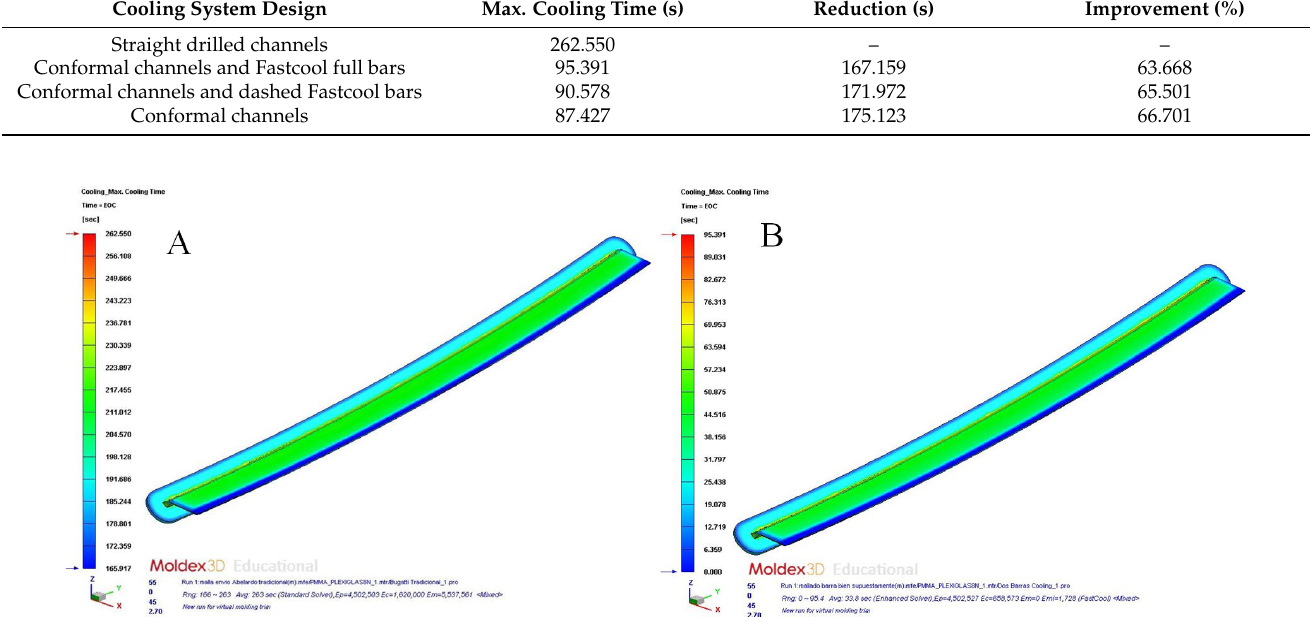
Figure 13. Maximum cooling time (s); straight drilled channels ( A ), conformal channels—Fastcool full bars ( B ).